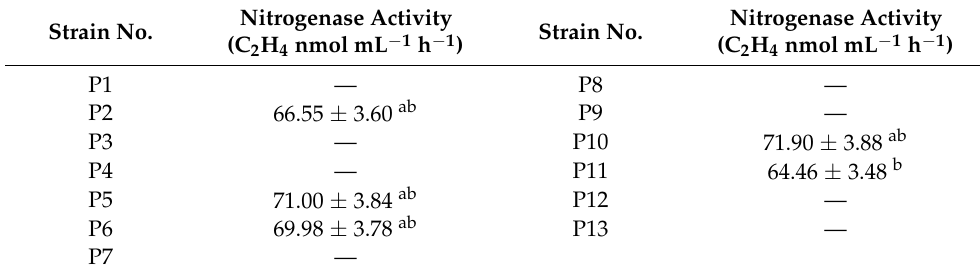
Table 3. Nitrogenase activity of phosphorus-dissolving bacteria. Strain No.